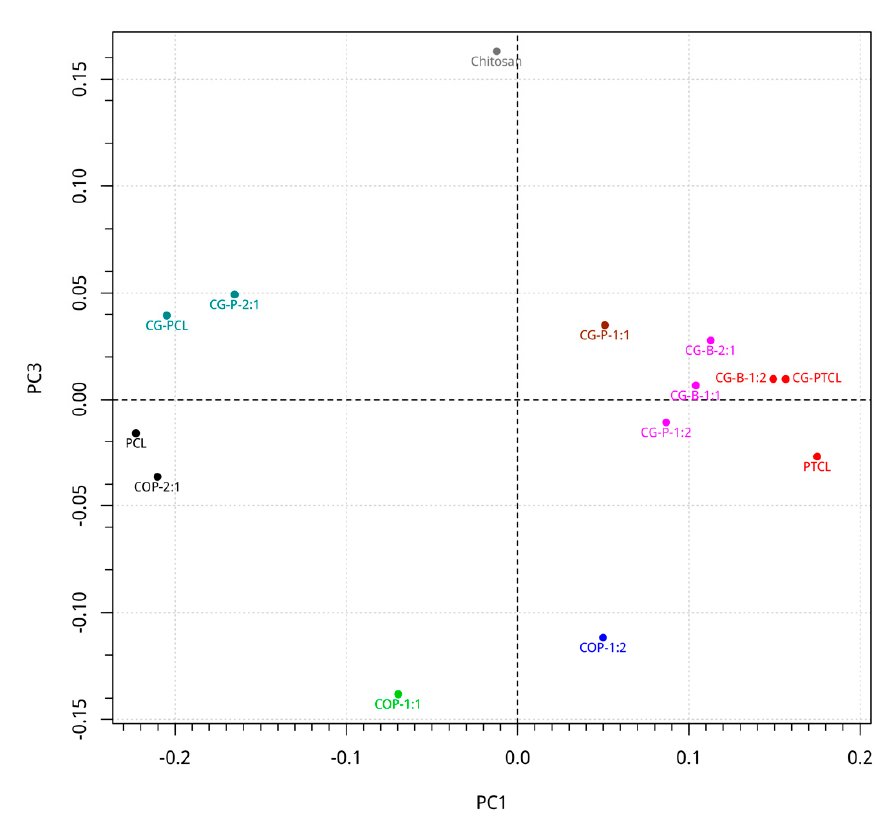
Figure 7. Scores plot of principal component analysis (PCA) applied to FTIR data.